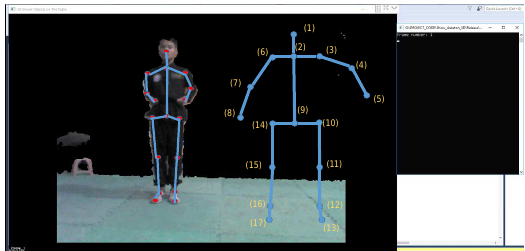
Fig. 8: Illustration marking of 3-D human pose annota- tion, in which the order of marking of key points is as follows: (1) Head, (2) Neck, (3) Right Shoulder, (4) Right Elbow, (5) Right Wrist, (6) Left Shoulder, (7) Left Elbow, (8) Left Wrist, (9) Center Hip, (10) Right Hip, (11) Right Knee, (12) Right Ankle, (13) Right Big Toe, (14) Left Hip, (15) Left Knee, (16) Left Ankle, (17) Left Big Toe.